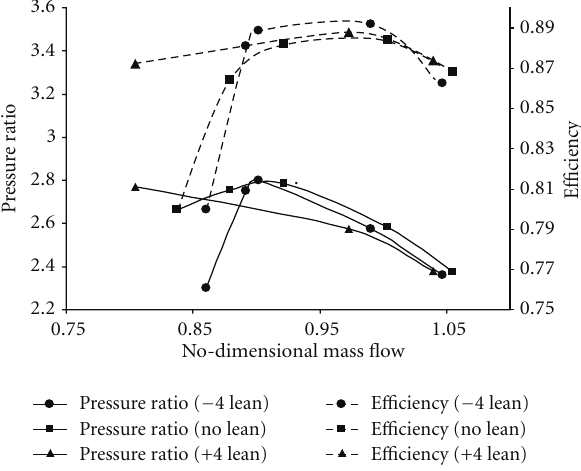
Figure 16: Compressor performance for a lean